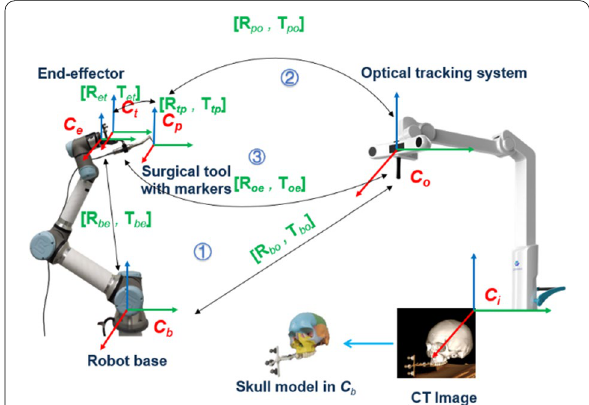
Figure 2 Diagram of multiple closed-loops calibration